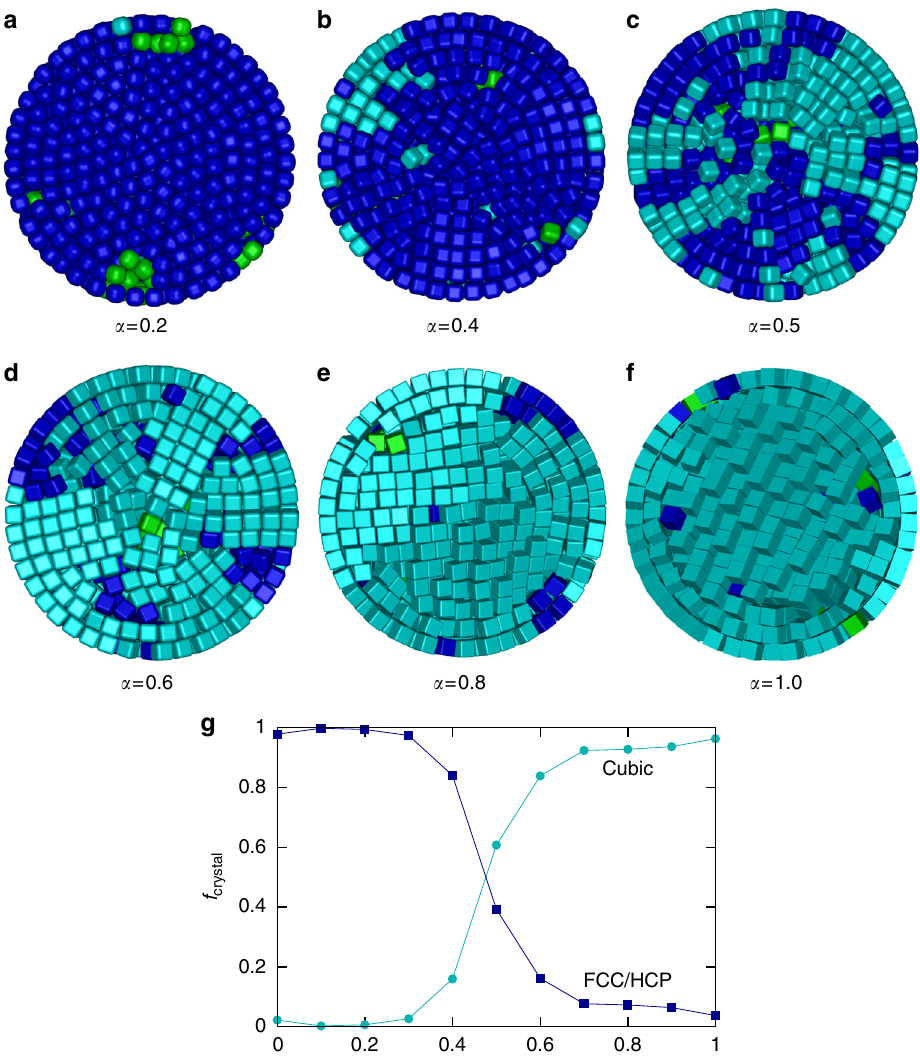
Fig. 6 Transition from FCC/HCP to SC. Cut-through views of a – f typical con fi gurations of SPs of cubes with different asphericity α = 0.2, 0.4, 0.5, 0.6, 0.8, and 1.0 as obtained from simulations. The dark blue cubes have FCC/HCP order and the cyan particles have cubic order. The green cubes are not crystalline. g The fraction of crystalline cubes that is in an environment with cubic symmetry (cyan) and the fraction of crystalline cubes that is in an environment with FCC/HCP symmetry (dark blue) as a function of